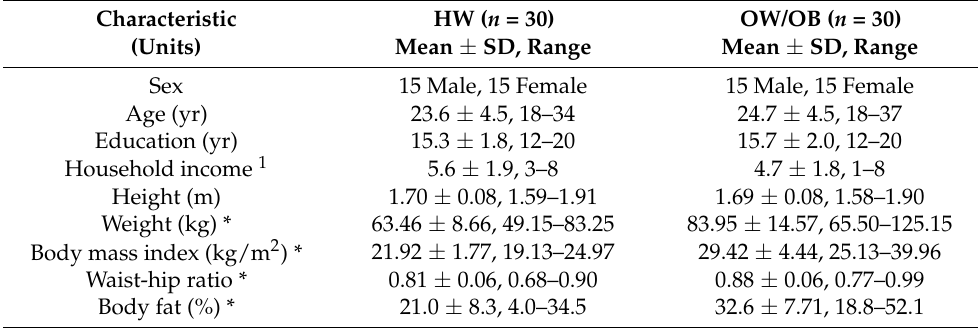
Table 3. Participant characteristics of the full sample ( n =